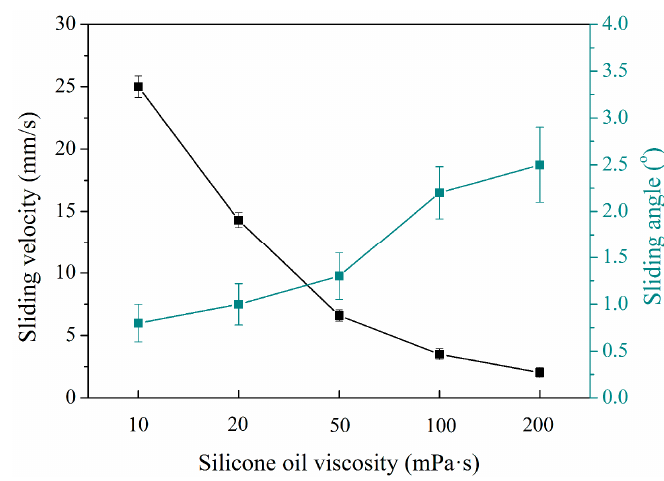
Figure 5. The sliding angles and sliding velocities of the SLIPSs filled with various viscosities of silicone